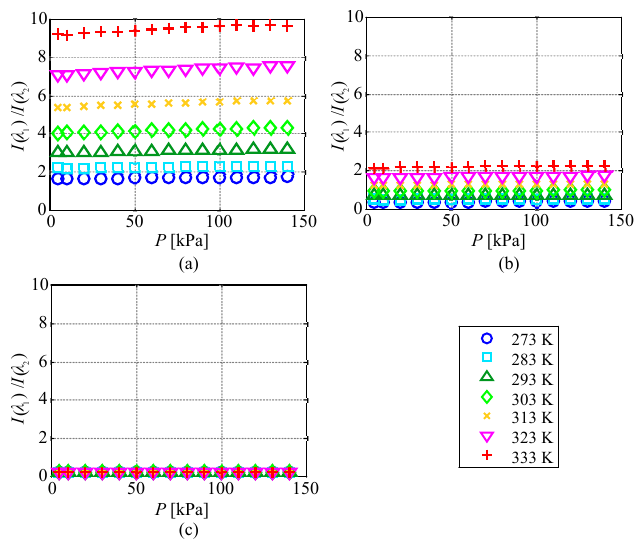
Figure 15. Ambient pressure evolution of the ratio of the emission intensities at two wavelengths for each temperature condition. ( a ) λ 1 = 616 nm, λ 2 = 491 nm; ( b ) λ 1 = 616 nm, λ 2 = 545 nm; ( c ) λ 1 = 491 nm, λ 2 = 545 nm.